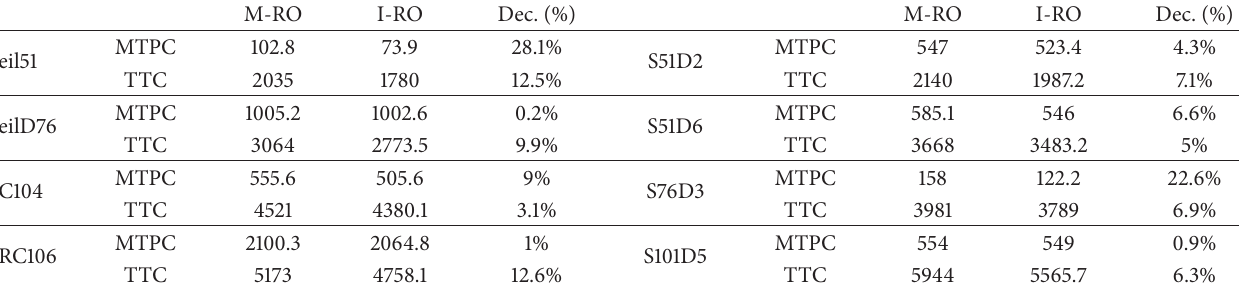
Table 2: Calculated results: IRO and